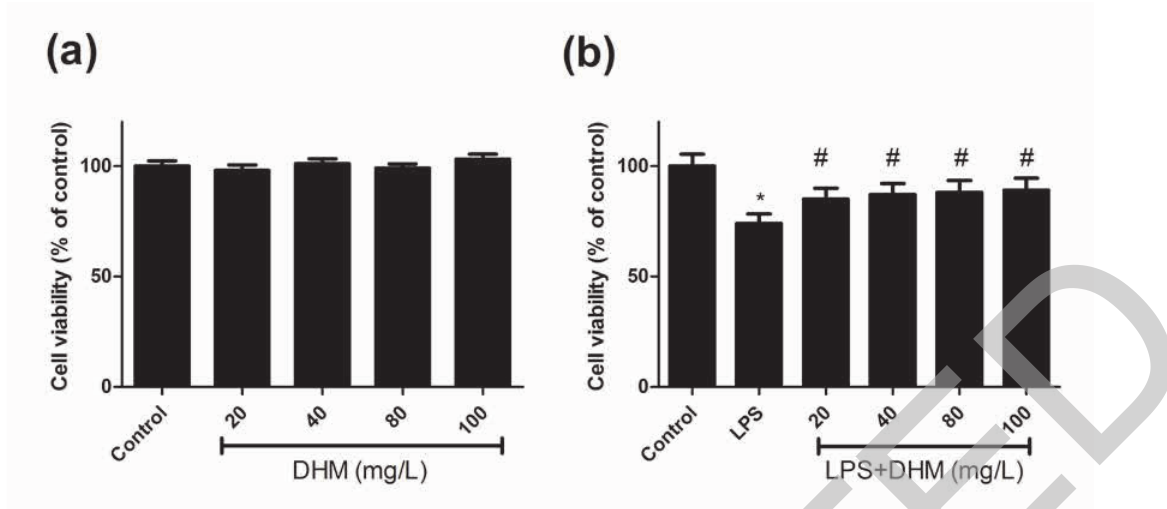
Figure 3: The effects of various concentrations of DHM (20, 40, 80 or 100mg/L) on mRNA levels of nitric oxide synthase (iNOS) and cyclooxy- genase 2 (COX-2). (a) DHM (20, 40, 80 or 100mg/L) significantly suppressed the LPS-induced increased mRNA level of iNOS. (b) DHM (20, 40, 80 or 100mg/L) significantly suppressed the LPS-induced increased mRNA level of COX-2. *P<0.01 compared with control group; # P<0.01 compared with LPS group; Δ P<0.01 compared with DHM 20 or 40 mg/L groups.